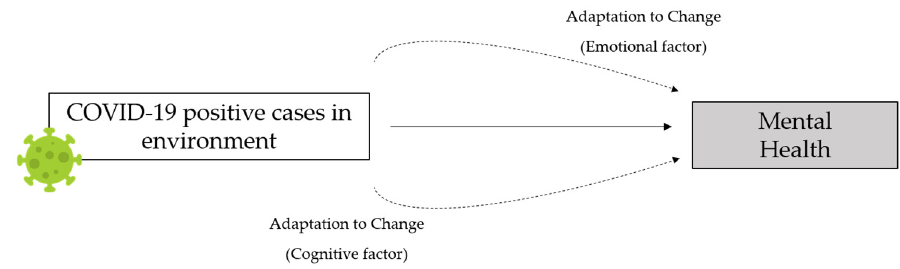
Figure 1. Hypothesized model of the mediating role of adaptation to change on the effect of COVID-19 on mental health.